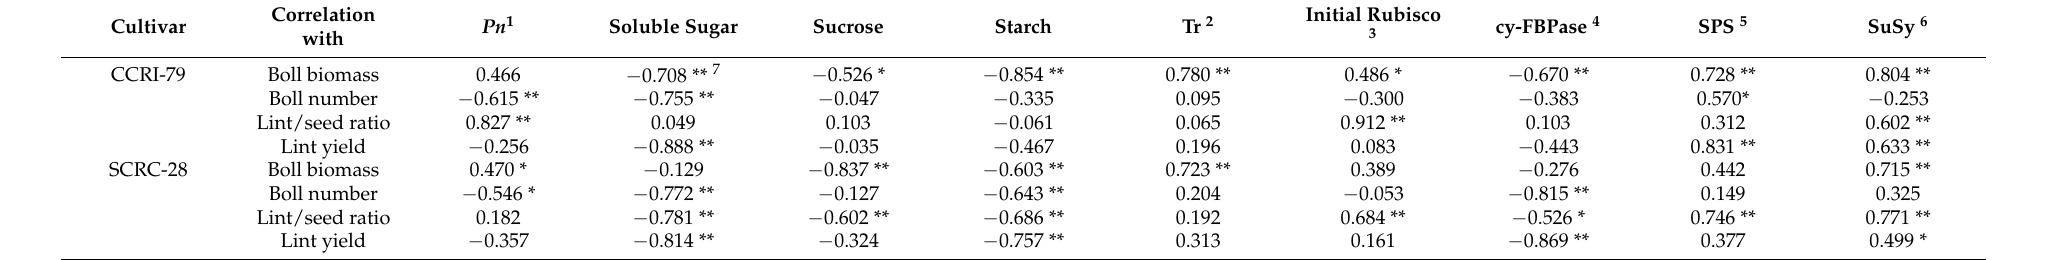
Table 7. Correlation between source indices, lint yield, and yield components in 2019 and 2020. (n = 18, R 0.05 = 0.468, R 0.01 = 0.590).